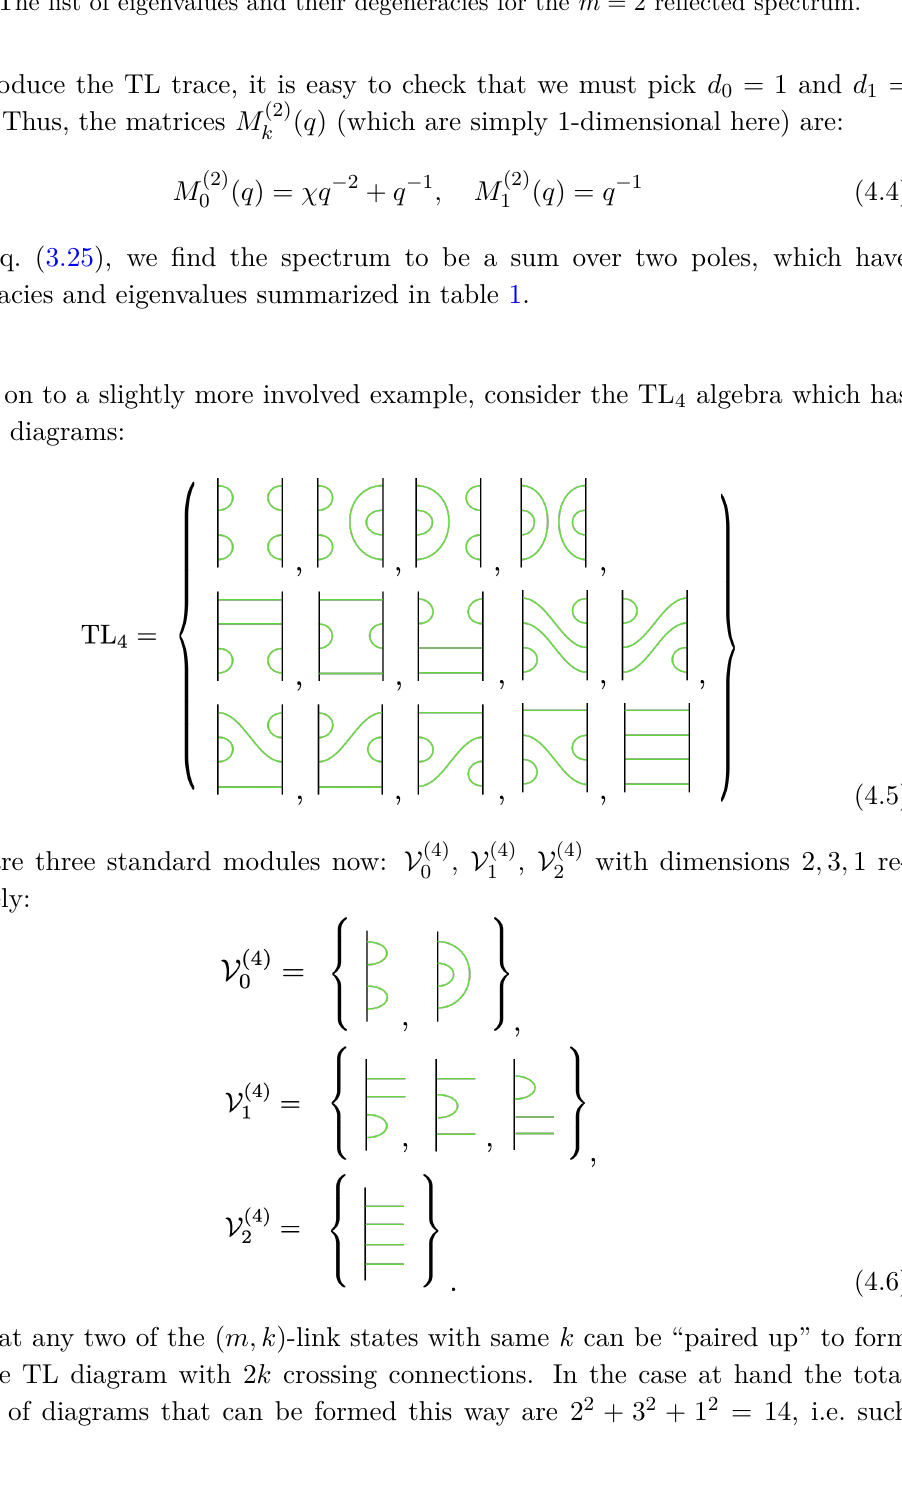
Table 1 . The list of eigenvalues and their degeneracies for the m = 2 reflected